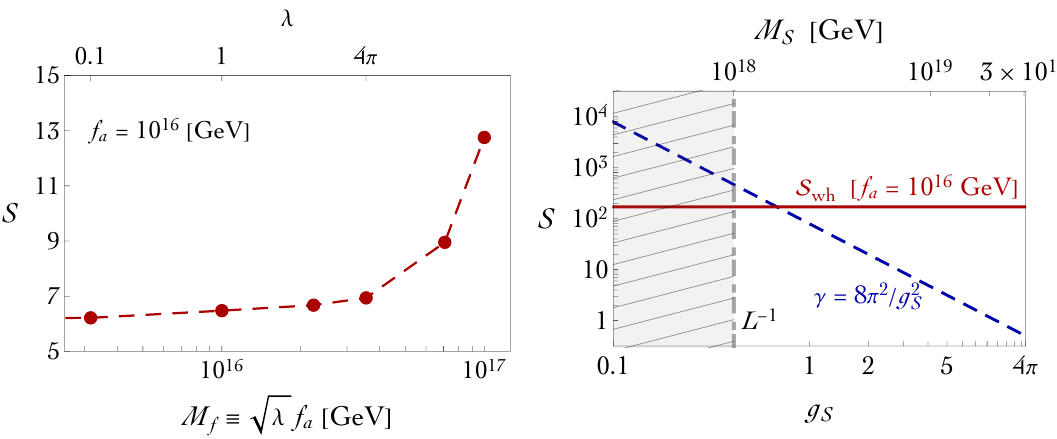
Figure 4 . Left panel. On-shell action in the presence of a dynamical radial mode as a function of its mass M f . Right panel. Instanton action as a function of the string coupling g S . On the top x-axis we show the value of the string mass scale M S . In solid red, we show the on-shell action S inst for the instanton at the critical value f a = 10 16 GeV. The blue dashed line represents the string contribution 8 (cid:25) 2 = g 2 . The region shaded in gray corresponds to M S < L (cid:0) 1 S